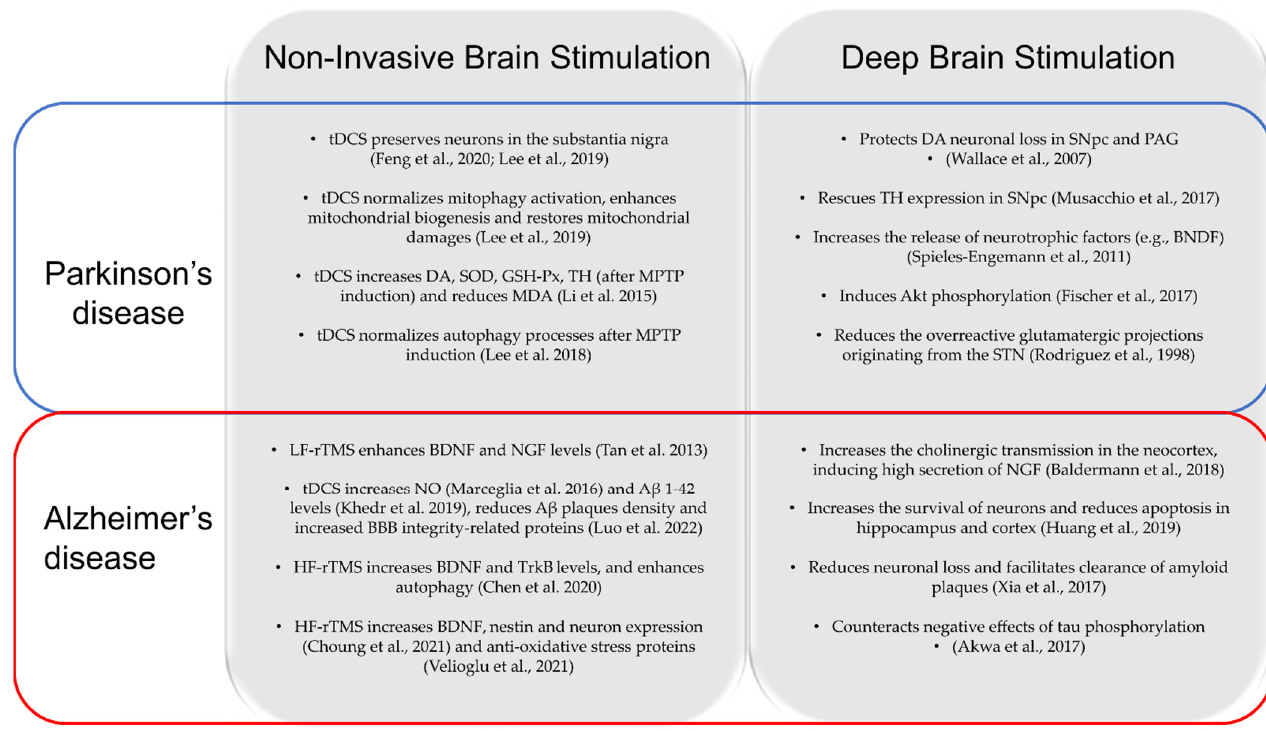
Figure 3. Schematic overview of comparisons in neuroprotective effects between NIBS and DBS. tDCS = transcranial direct current stimulation; DA = dopamine; SOD = superoxide dismutase; GSH-PX = glutathione peroxidase; TH = tyrosine hydroxylase; MPTP = 1-methyl-4-phenyl-1,2,3,6-tetrahydropyridine; MDA = malonaldehyde; LF-rTMS = low frequency repetitive transcranial magnetic stimulation; BDNF = Brain-Derived Neurotrophic Factor; NGF = nerve growth factor; NO = nitric oxide; A β = amyloid- β peptide; BBB = blood brain barrier; HF-rTMS = high frequency repetitive transcranial magnetic stimulation; TrkB = Tropomyosin receptor kinase B; SNpc = substantia nigra pars compacta; PAG = periaqueductal grey matter; Akt = Protein kinase B; STN = subthalamic nucleus. Feng et al., 2020 [44]; Lee et al., 2019 [17]; Li et al. 2015 [19]; Lee et al. 2018 [45]; Tan et al. 2013 [73]; Marceglia et al. 2016 [83]; Khedr et al. 2019 [90]; Luo et al. 2022 [88]; Chen et al. 2020 [74]; Choung et al., 2021 [70]; Velioglu et al., 2021 [71]; Wallace et al., 2007 [100]; Musacchio et al., 2017 [101]; Spieles-Engemann et al., 2011 [102]; Fischer et al., 2017 [103]; Rodrigues et al., 1998 [104]; Baldermann et al., 2018 [105]; Huang et al., 2019 [106]; Xia et al., 2017 [107]; Akwa et al., 2017 [108].